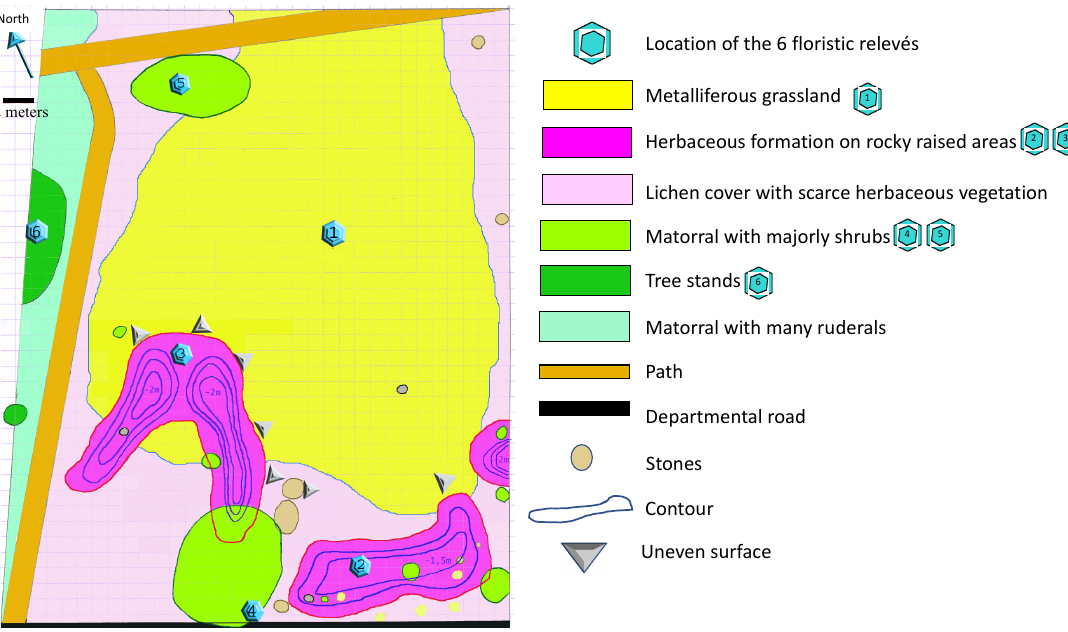
Figure 3. Cartography of the mosaic of micro-habitats at an abandoned mine site at La Gardie. Icons with number indicate the number of the relevé and its location in the field (bar = 2 m). Table 2. Floristic list established during springtime and occurrence of each plant species in the 6 relevés out of the 4 selected micro-habitats encountered at the former mine site. * (1): Metalliferous grassland; (2) and (3): Herbaceous formation on rocky raised areas; (4) and (5): Matorral with majorly shrubs; (6): Tree stands and frequency out of the 6 relevés.